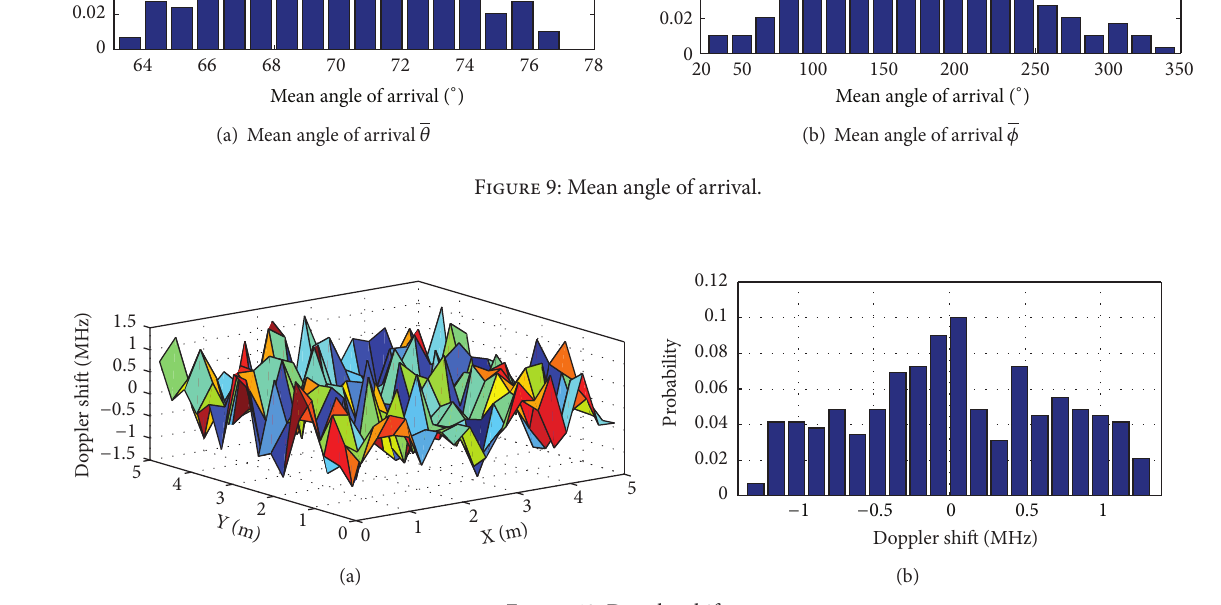
Figure 10: Doppler